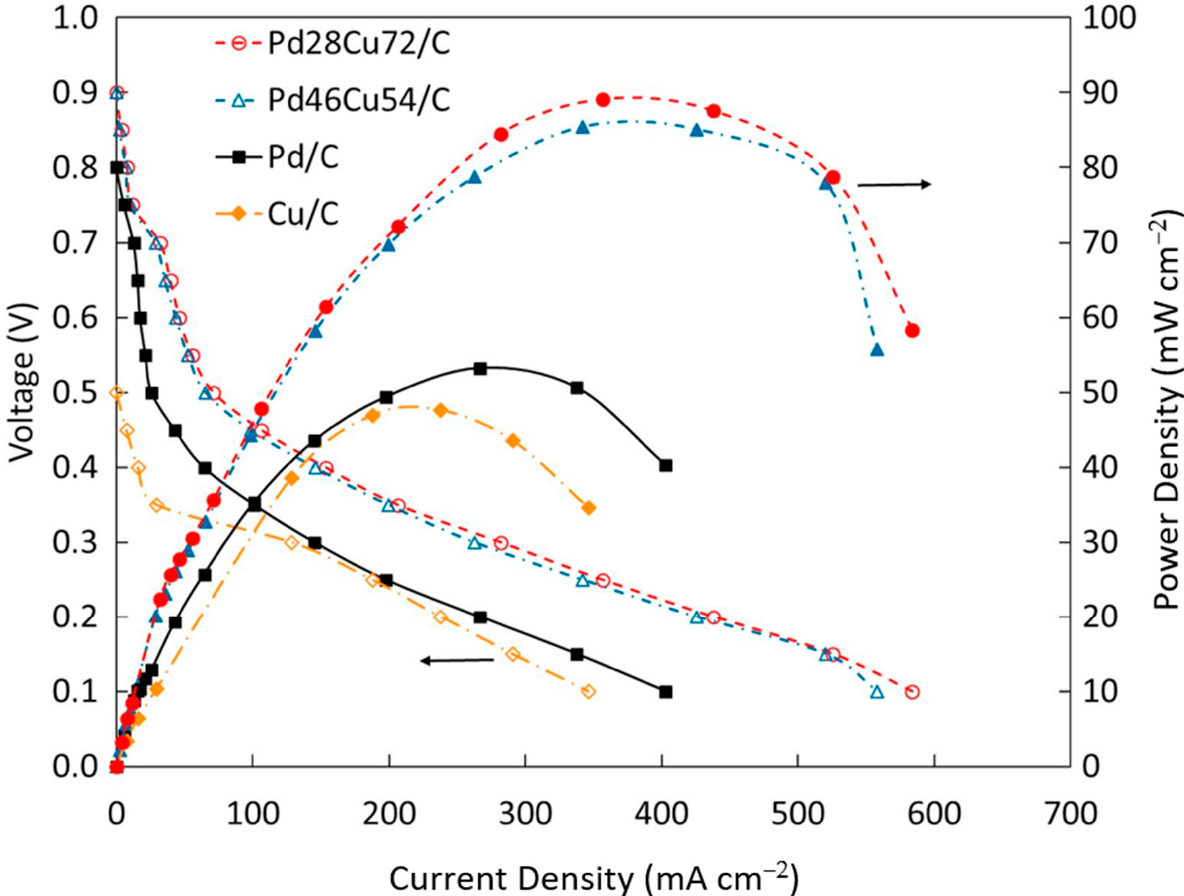
Figure 4. Voltage–current plots of alkaline DAAFC at 60 °C with 1 M ascorbate +1 M KOH (anode) and oxygen (cathode). Reproduced with permission [37]. Copyright 2018 Elsevier Ltd.